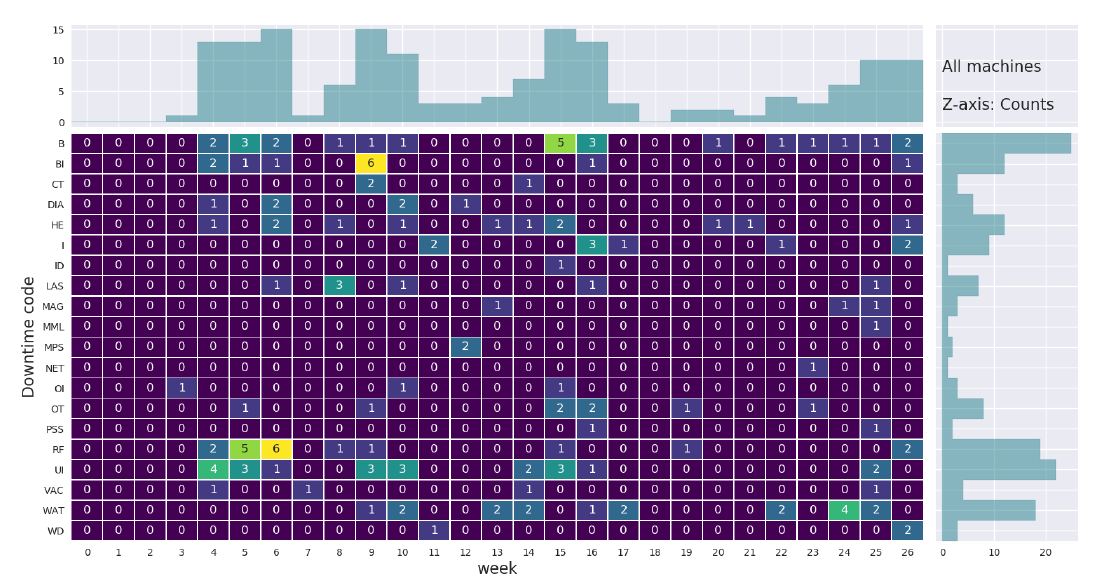
Figure 16. Heatmap of downtime at MAX IV as a function of event code and week number for all three machines (I, R3,